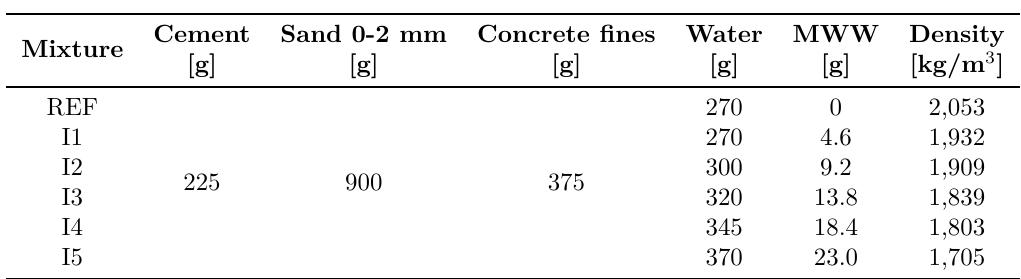
Table 1. Composition of plaster mortar